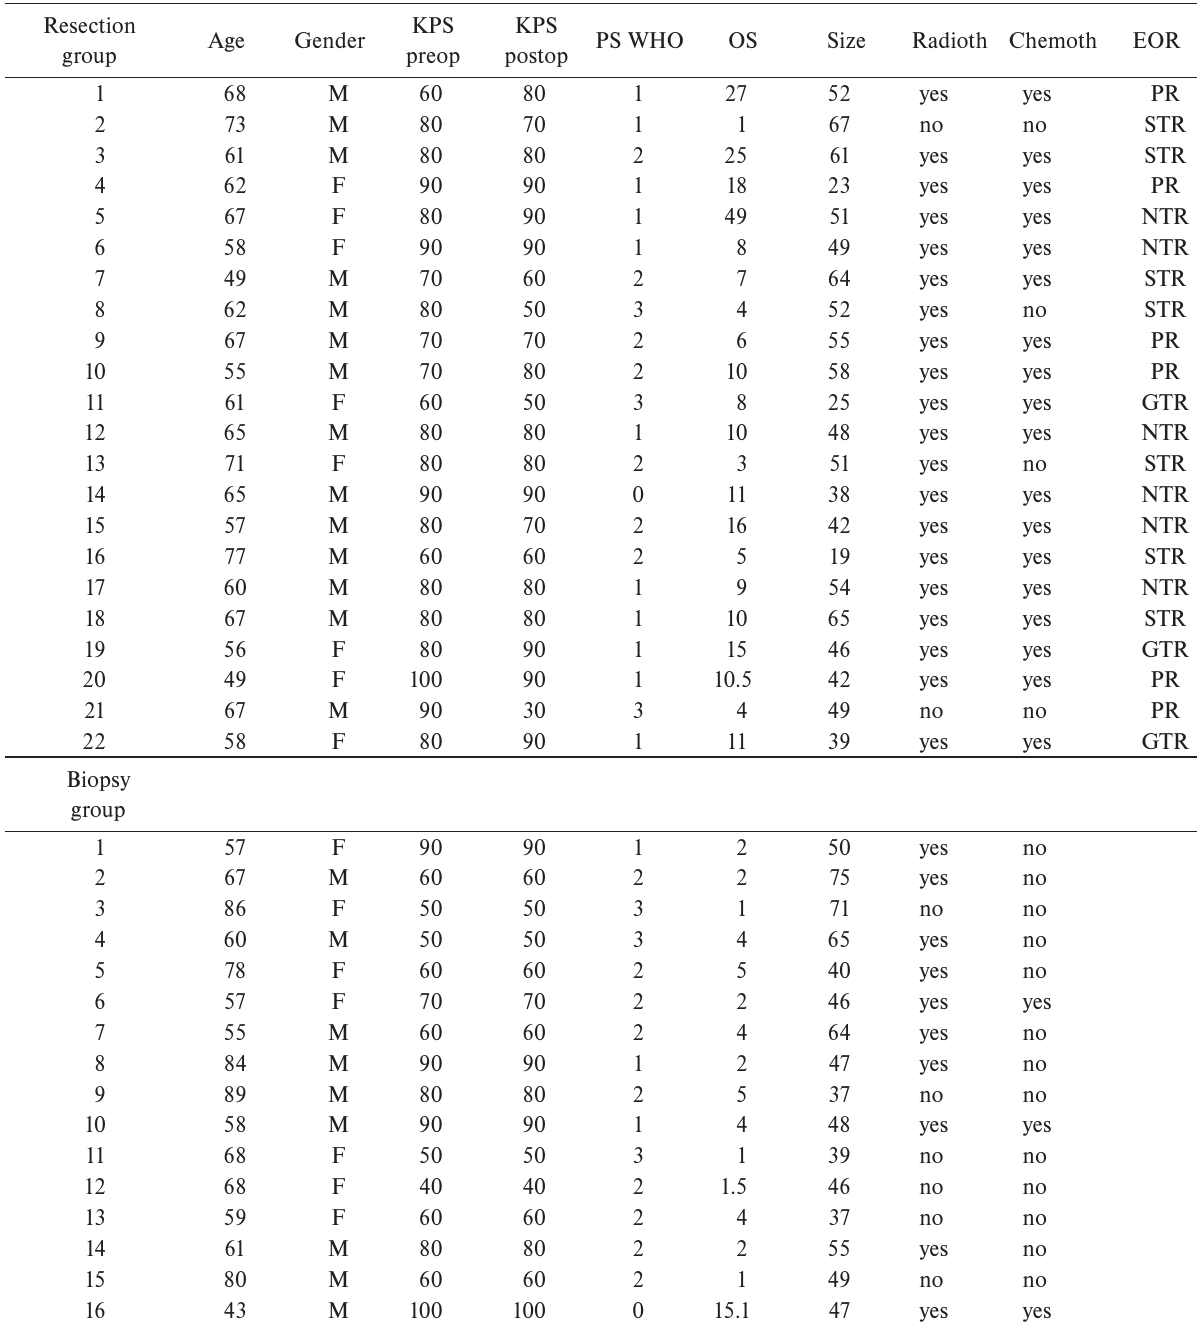
Table 2. Details of